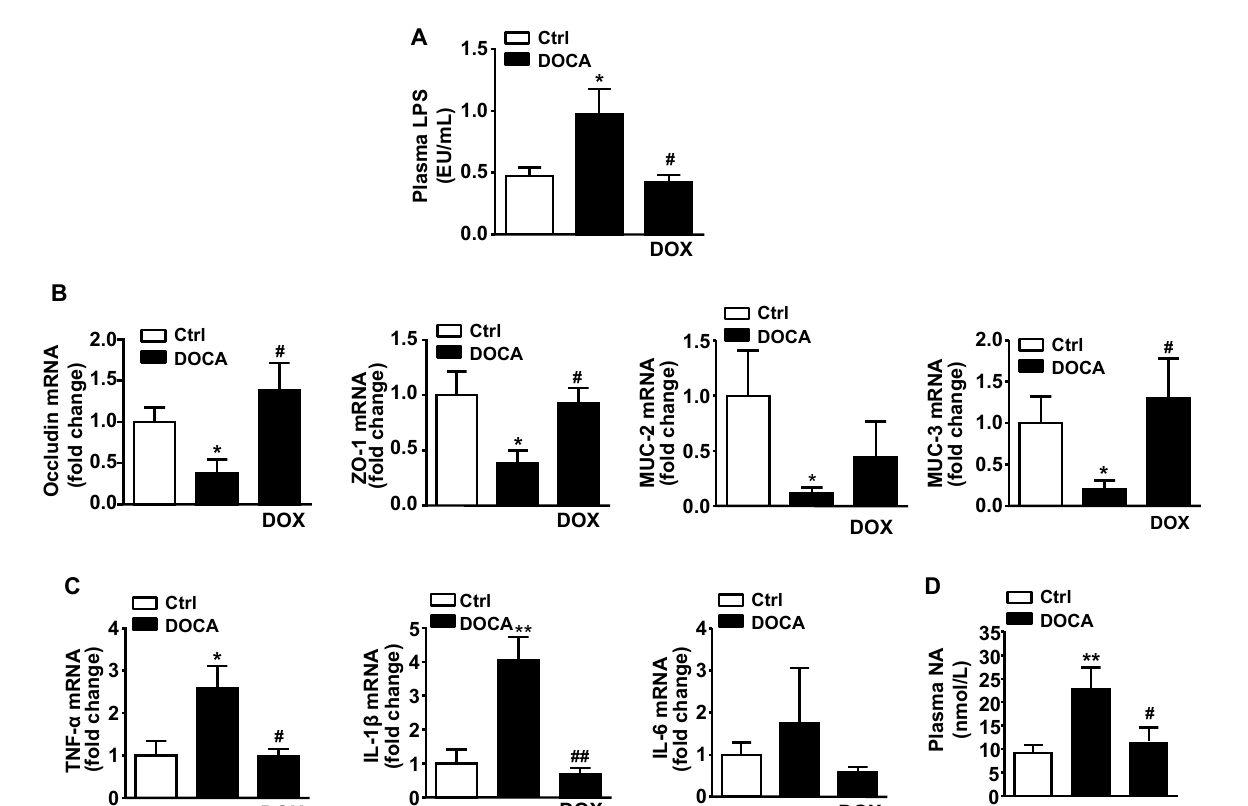
Figure 4. Doxycycline (DOX) improved intestinal integrity and inflammation, ane reduced endotoxemia and plasma noradrenaline levels in DOCA-salt rats. ( A ) Plasma endotoxin concentrations (EU/mL, endotoxin units/mL). ( B ) mRNA levels in colon of occludin, zonula occludens-1 (ZO-1), mucin (MUC)-2 and MUC-3. ( C ) mRNA levels of pro-inflammatory cytokines in colon, tumour necrosis factor- α (TNF- α ) and interleukin (IL)-6. ( D ) Plasma noradrenaline (NA) levels (nmol/L). Data represented as mean ± SEM ( n = 8). * p < 0.05 and ** p < 0.01 versus Control (Ctrl) group. # p <0.05 and ## p < 0.01 versus the non-treated DOCA group.